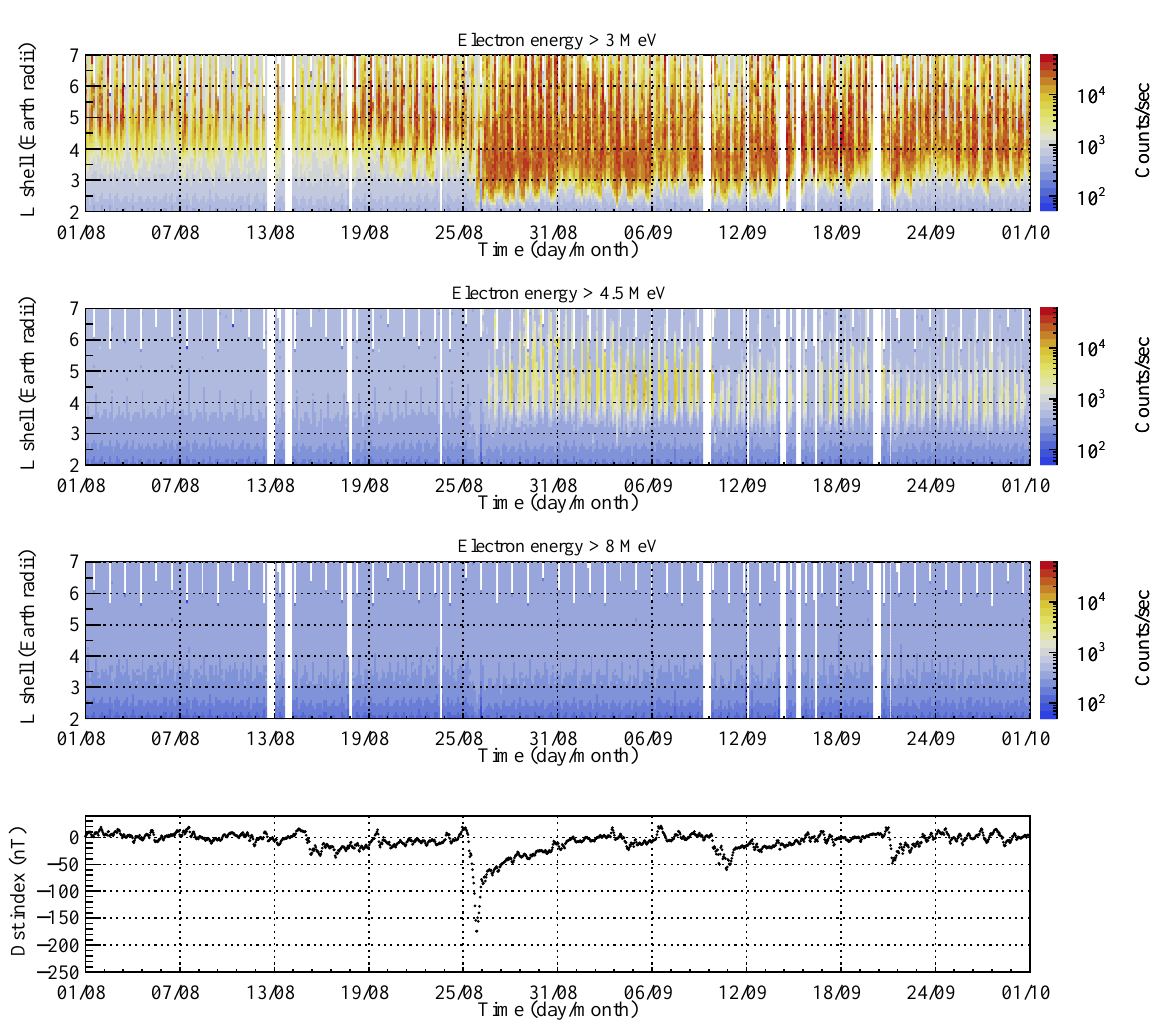
Figure 5. Top three panels: Trigger rates for three different HEPD configurations over the period August-September 2018; from top to bottom, T, T & P1, and T & P1 & P2. Adding more calorimeter planes to the trigger configuration results in increasing the energy threshold for electron detection ( > 3 MeV for T, > 4.5 MeV for T & P1, and > 8 MeV for T & P1 & P2). The proton contribution to the trigger rate increase is negligible due to the absence of direct injection from SEPs. The vertical white lines are due to a lack of data. Bottom panel: Time evolution of the Dst